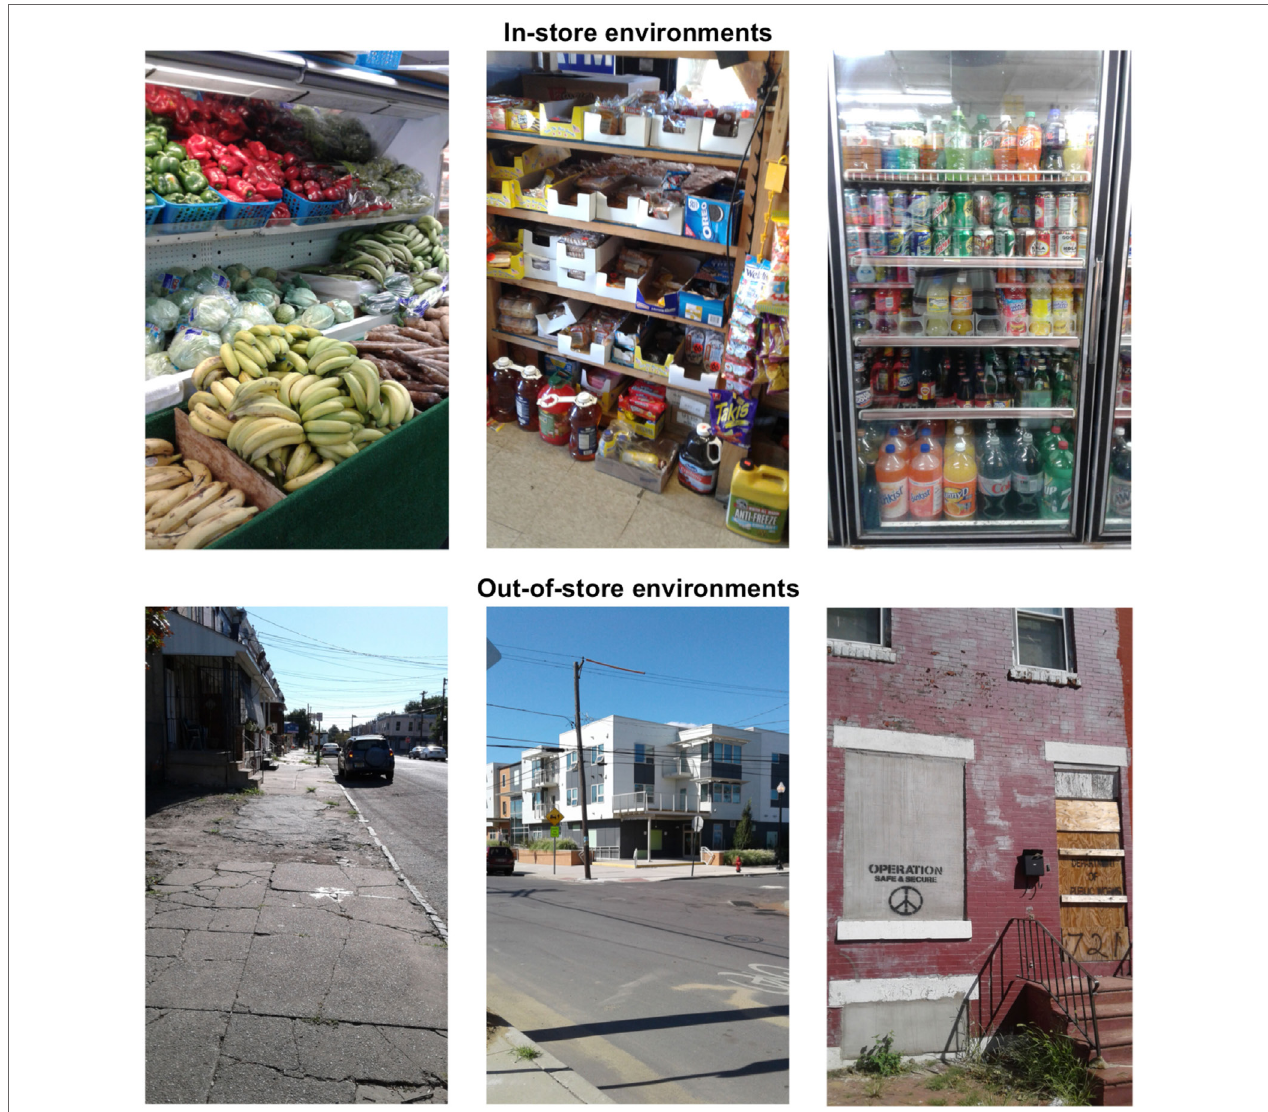
FiguRE 2 | Example photographs taken by citizen scientists with the discovery tool application in Camden, New Jersey (September